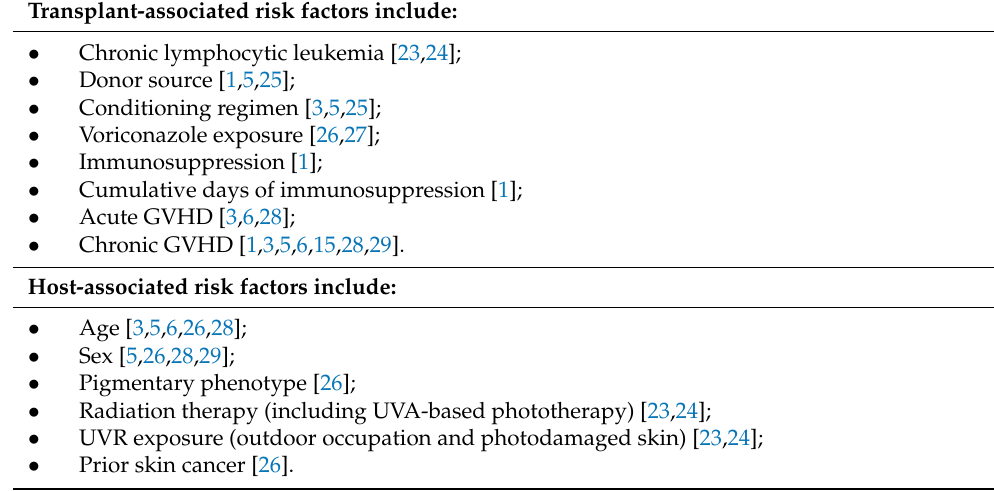
Table 1. List of transplant-associated and host-associated risk factors which correlate with increased risk of squamous cell carcinoma